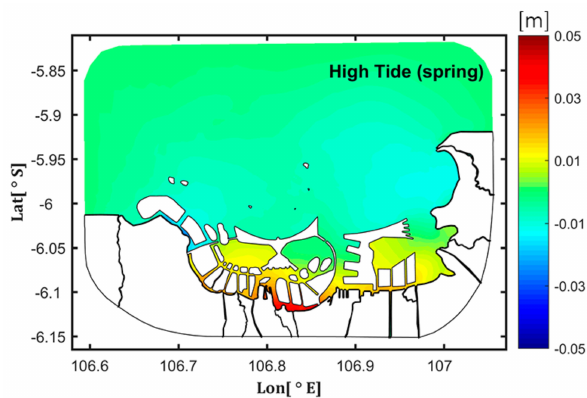
Figure 11. Changes in water elevation (m) between scenario 1 and after the Giant Seawall